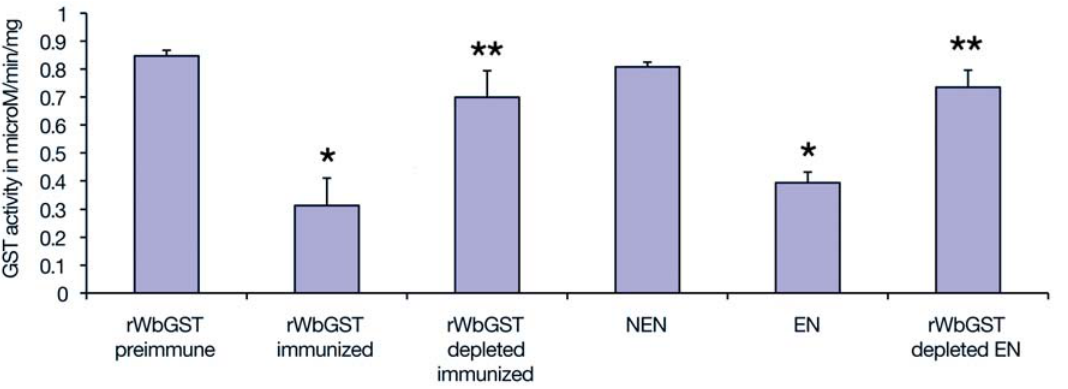
Figure 6. Anti-WbGST antibodies can neutralize the enzymatic activity of rWbGST. rWbGST was added to various test sera (pooled EN sera, sera from mouse immunized with rWbGST, EN and mouse sera depleted of anti WbGST antibodies) and incubated for 1 hr at 37 u C followed by another incubation at 4 u C for 4 h. Following incubation, GST enzyme activity was determined spectrophotometrically at 340 nm by measuring enzymatic conjugation of glutathione with 1-chloro-2, 4-dinitrobenzene (CDNB). Individual bar represents mean 6 SD of GST activity ( m M/min/mg). Samples were read in triplicate wells. Data is representative of one of three similar experiments. Pre-immune sera from mice and sera from NEN individuals were used as control samples. * Significant (p , 0.005) compared to pre-immune or NEN sera samples. ** significant (p , 0.01) compared to non-depleted immune sera or EN sera samples.